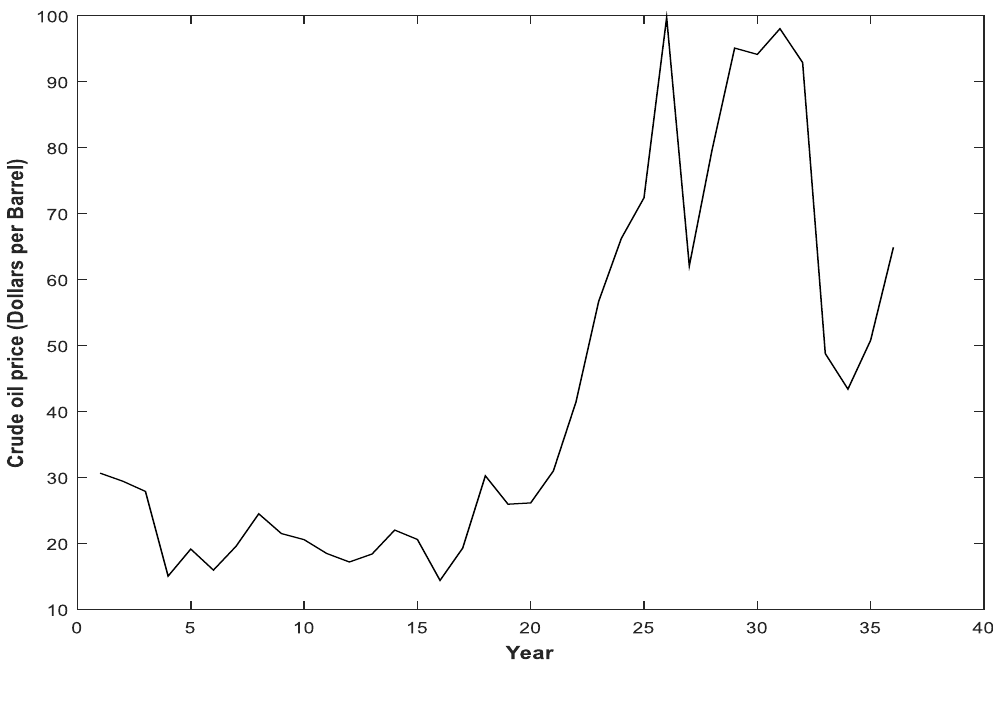
Figure 5. Yearly crude oil price